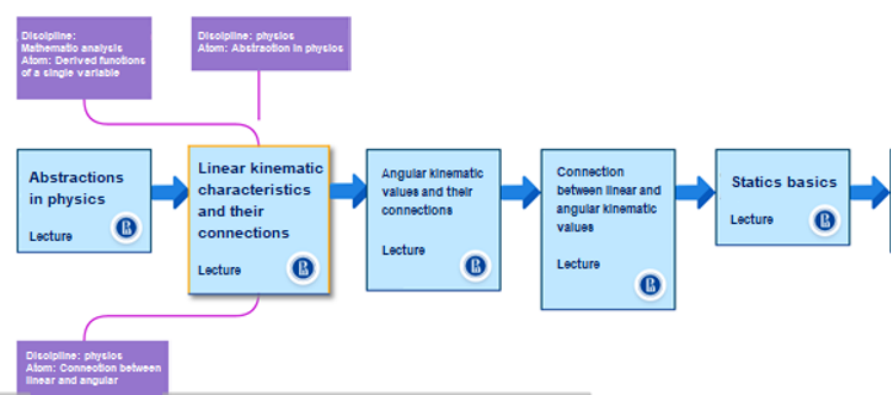
Fig. 5. Visualization of the students educational